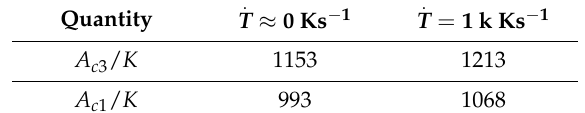
Table 1. Computed phase-transformation temperatures of 22MnB5; quasi-static according to [24], and rapid heating.